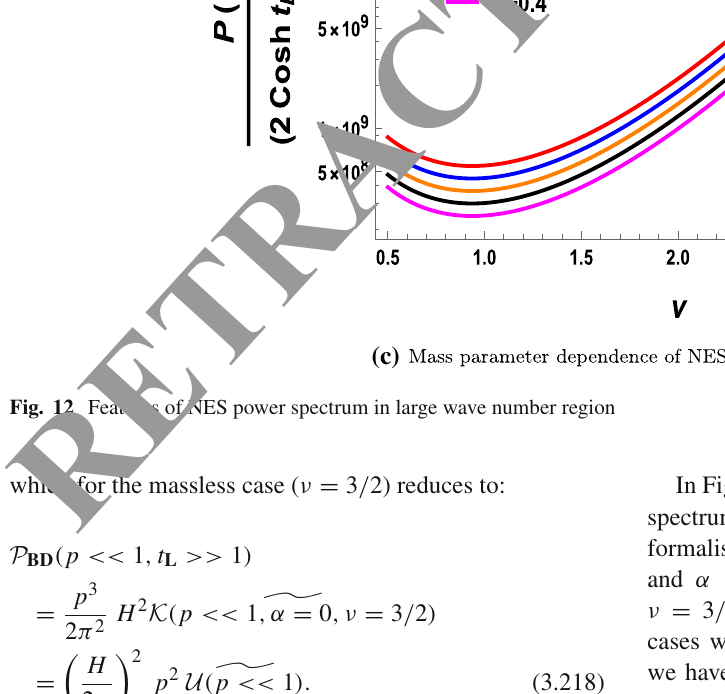
Fig. 12 Features of NES power spectrum in large wave number region